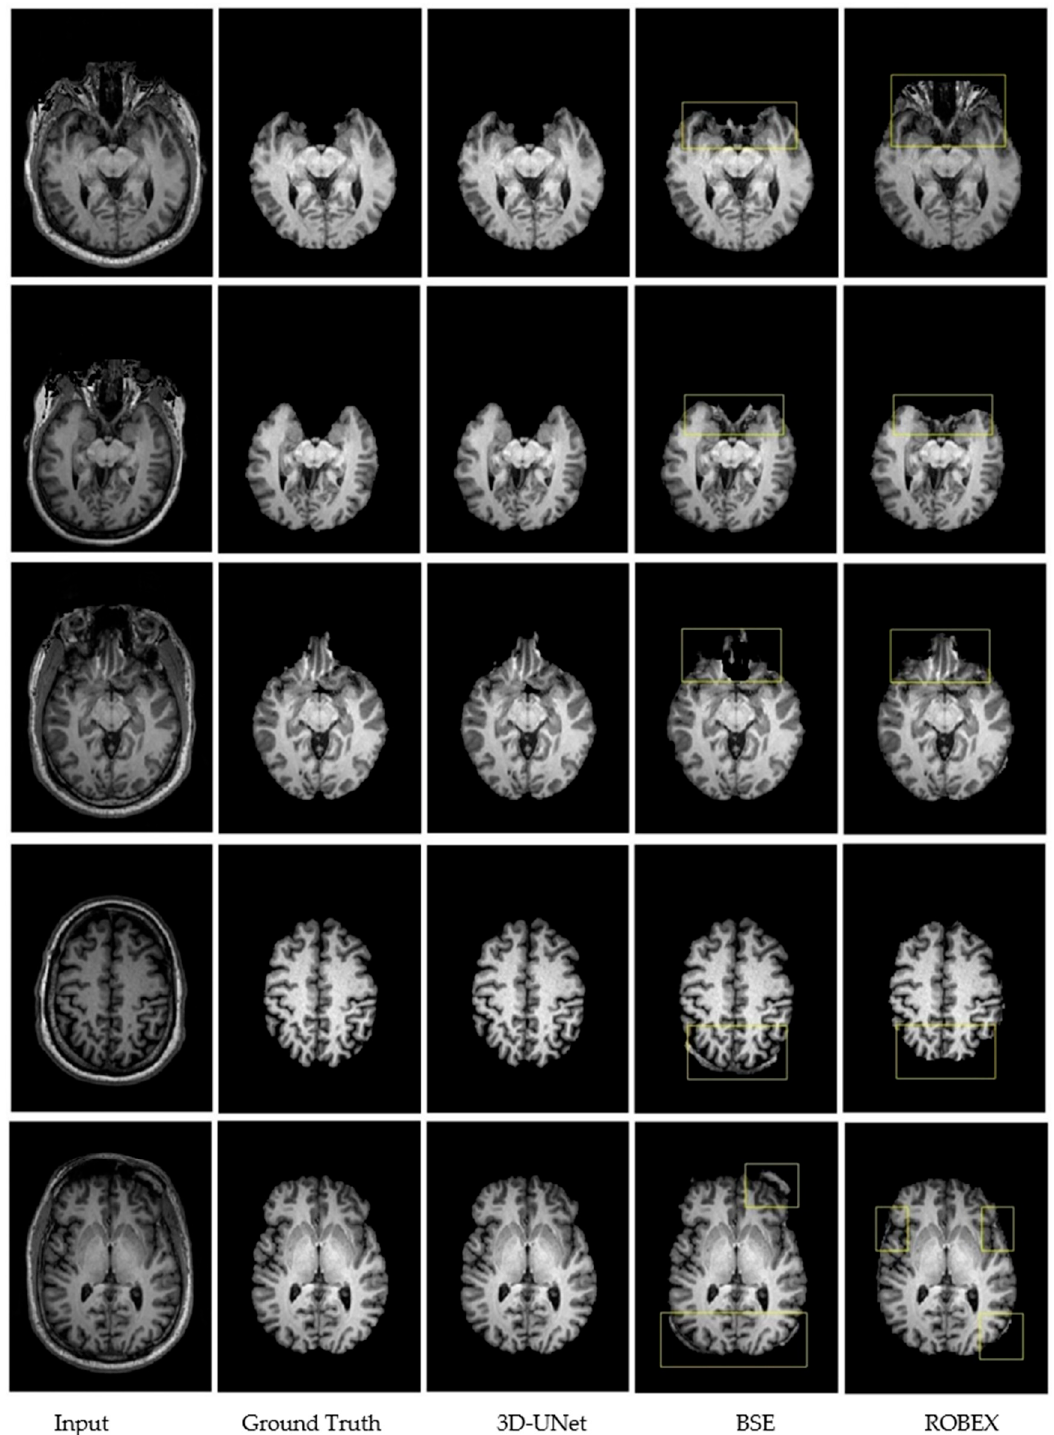
Figure 6. Qualitative performance comparison of the proposed method. Small rectangles indicate segmentation failure produced by BSE and ROBEX.